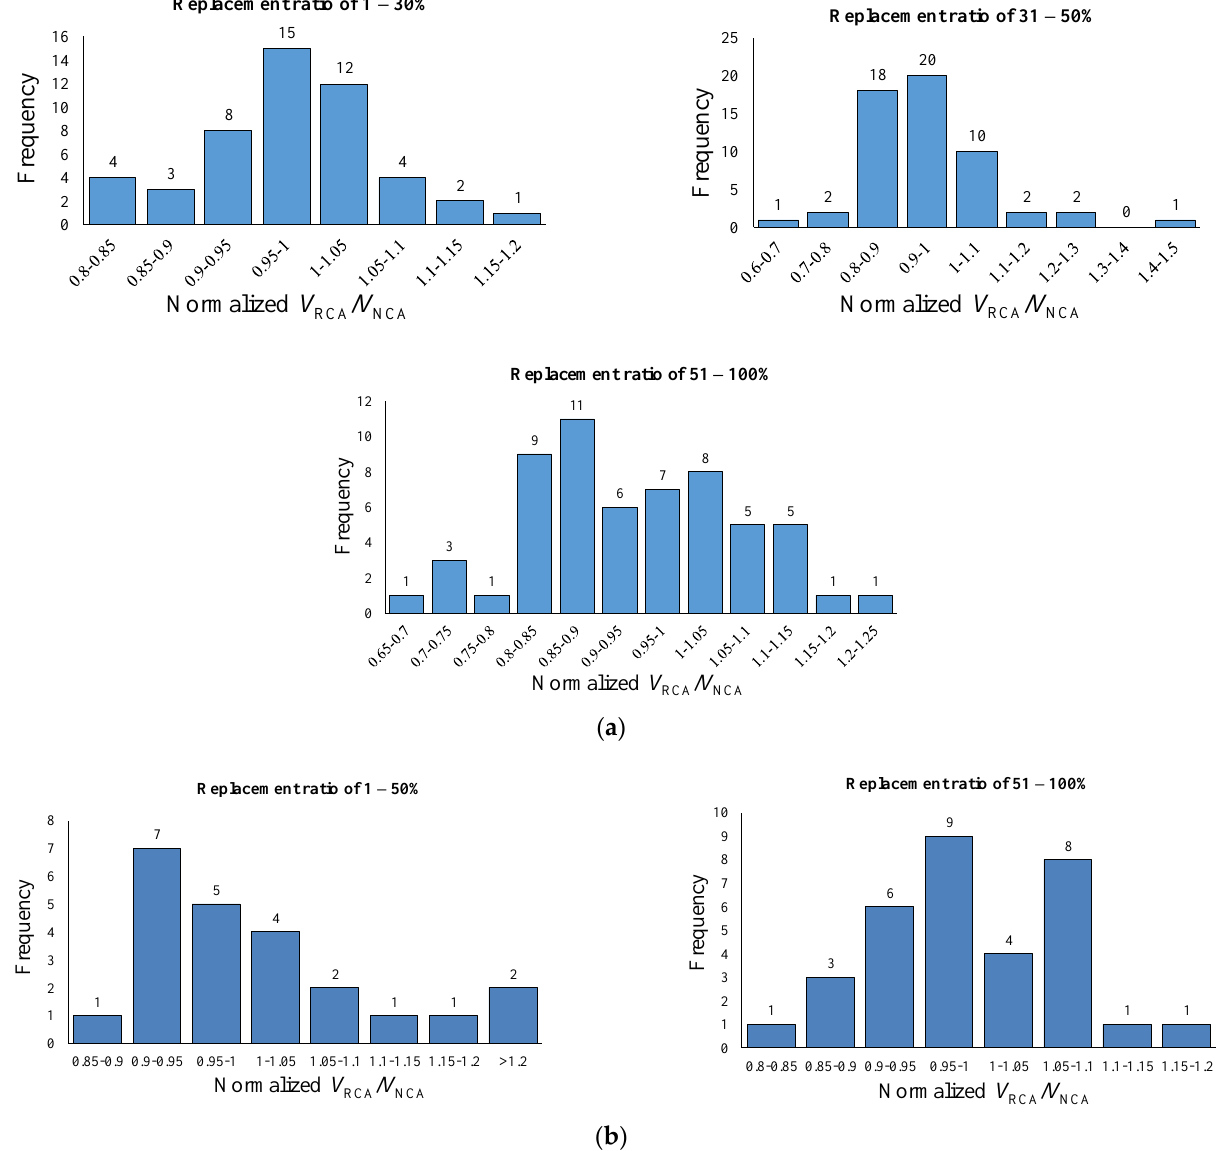
Figure 5. Distribution of normalized ratio in database. ( a ) Specimens without shear reinforcement. ( b ) Specimens with shear reinforcement.